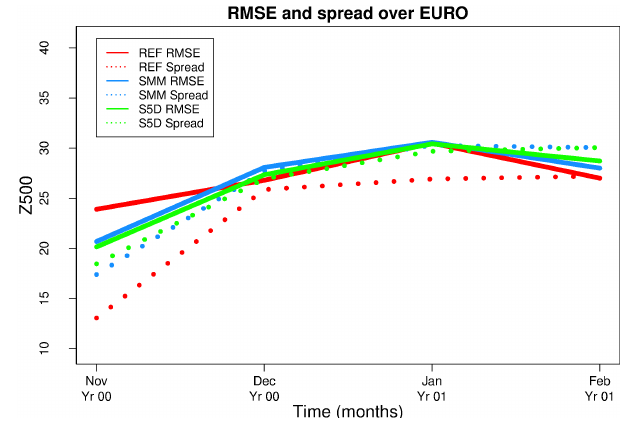
Figure 11. Evolution of spread (dots) and RMSE (lines) with fore- cast time for 500hPa geopotential height over Europe in experi- ments REF (red), SMM (blue), and S5D